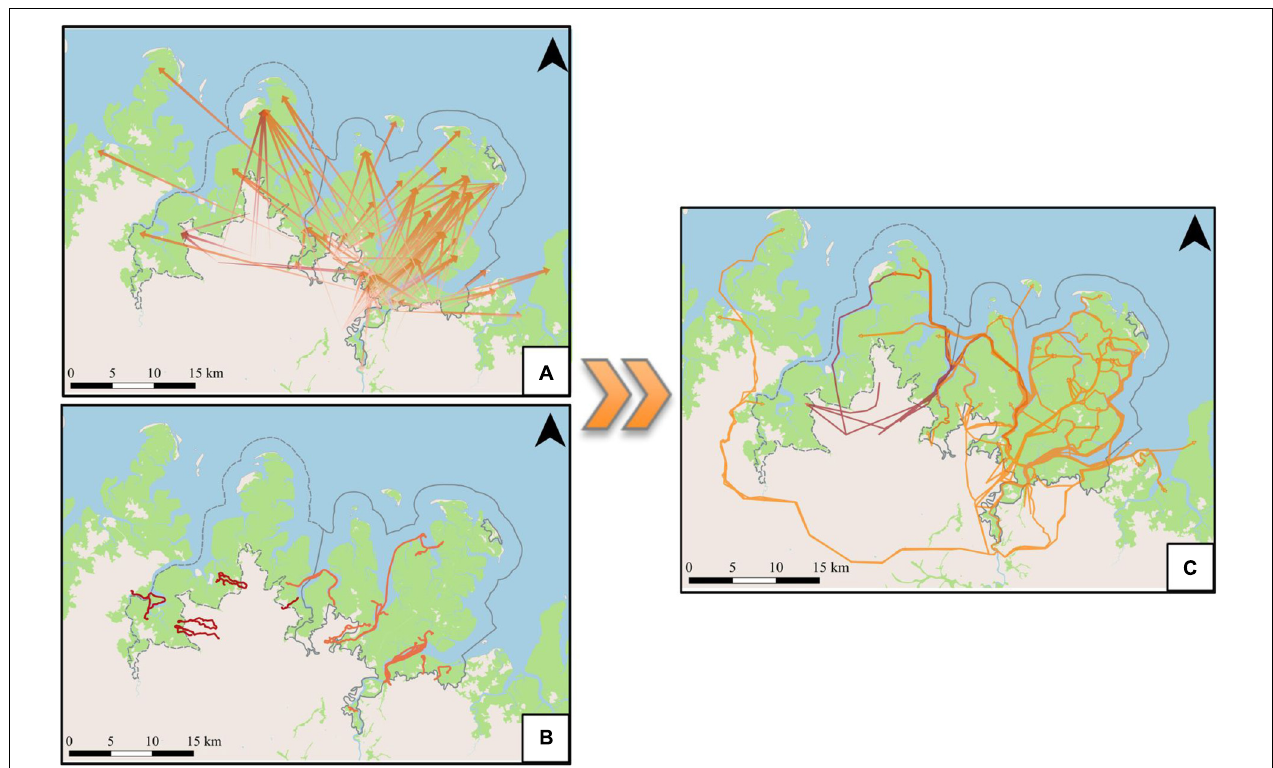
FIGURE 4 | Movements of fishers according to (A) participatory mapping; (B) GPS tracking; and (C) reconstruction combining the two datasets. Movements of fishers from Tracuateua are shown in red, while those from Bragança are shown in orange. The arrow bases in (A) and (C) represent the home villages, and the arrowheads the corresponding fishing grounds. The flows reflect the supply areas and the primary beneficiaries because only the catch is considered in this study, not the entire value chain of the fishing activity.